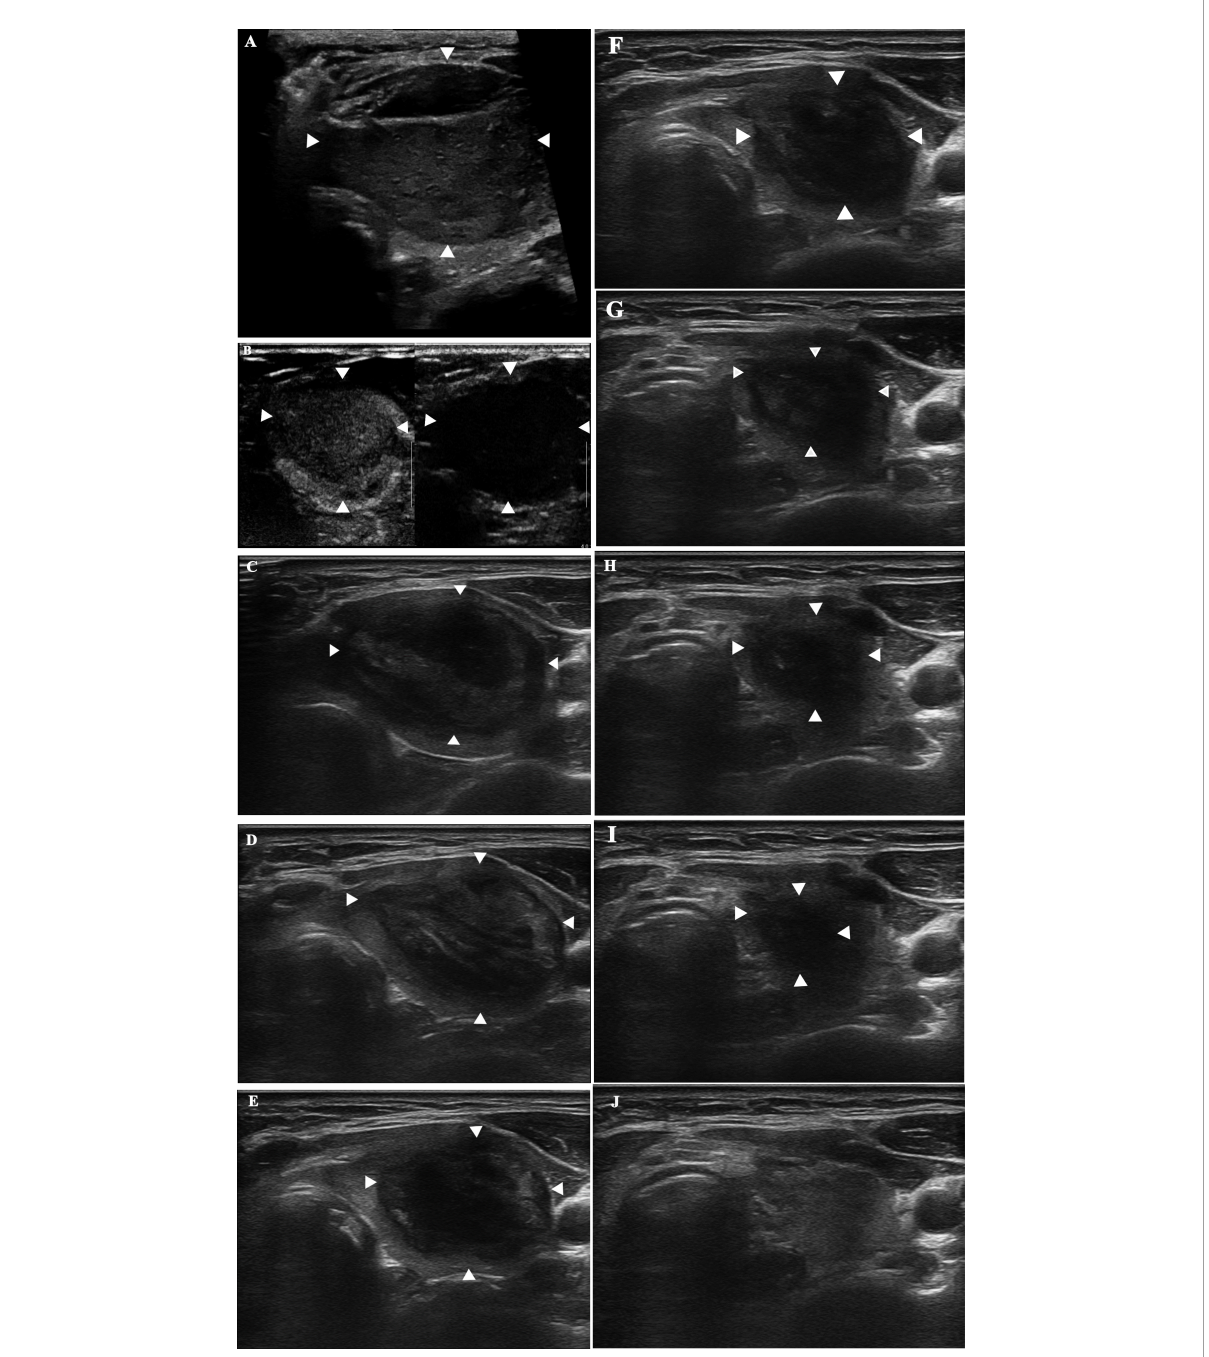
FIGURE 2 A 52-year-old woman with a diagnosis of a benign thyroid nodule in the left thyroid lobe. The images show the nodule before and during follow-up after MWA. (A) Before MWA, the nodule measures 4.6 cm × 3.1 cm × 3.5 cm in size and 26.1 cm 3 in volume. (B) CEUS shows uniform low enhancement of the nodule before MWA. (C) 1 month after MWA, the ablation area measures 4.4 cm × 2.8 cm × 3.3 cm in size and 21.3 cm 3 in volume. (D) 3 months after MWA, the ablation area measures 3.8 cm × 2.2 cm × 3.3 cm and 14.4 cm 3 in volume. (E) 6 months after MWA, the ablation area measures 3.4 cm × 2.1 cm × 2.3 cm and 8.6 cm 3 in volume. (F) 12 months after MWA, the ablation area measures 3.0 cm × 1.8 cm × 2.0 cm and 5.7 cm 3 in volume. (G) 18 months after MWA, the ablation area measures 2.5 cm × 1.3 cm × 1.5 cm and 2.6 cm 3 in volume. (H) 24 months after MWA, the ablation area measures 1.7 cm × 1.0 cm × 1.4 cm and 1.2 cm 3 in volume. (I) 30 months after MWA, the ablation area measures 1.3 cm × 0.6 cm × 1.0 cm and 0.4 cm 3 in volume. (J) 36 months after MWA, the ablation area has